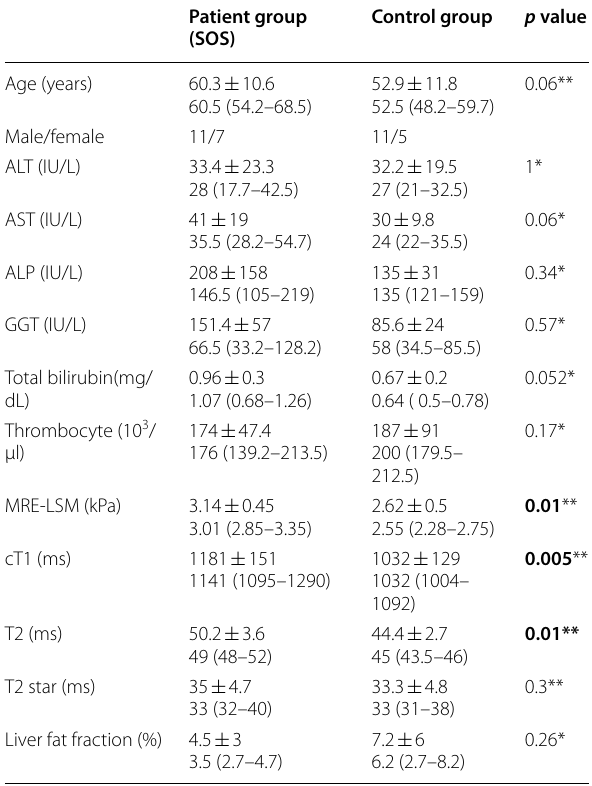
Table 1 Comparison of variables in patients with SOS